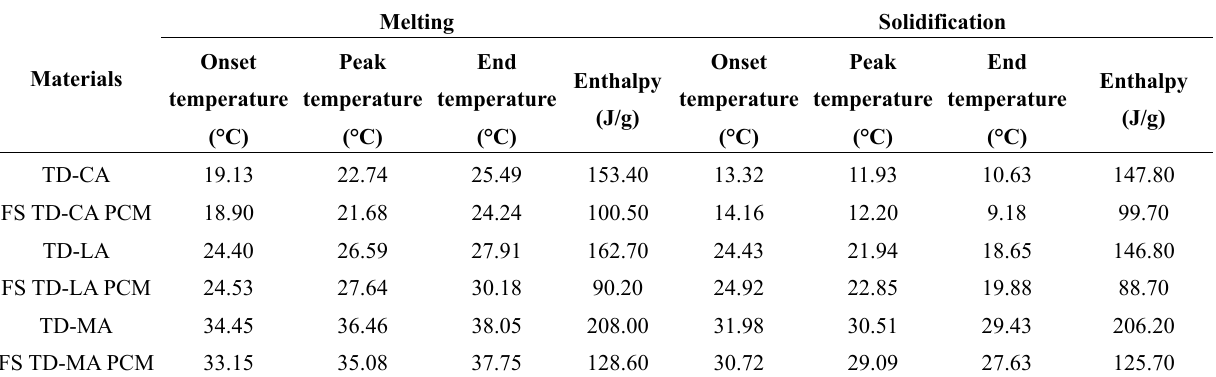
Table 5. Thermal properties of PCMs and their